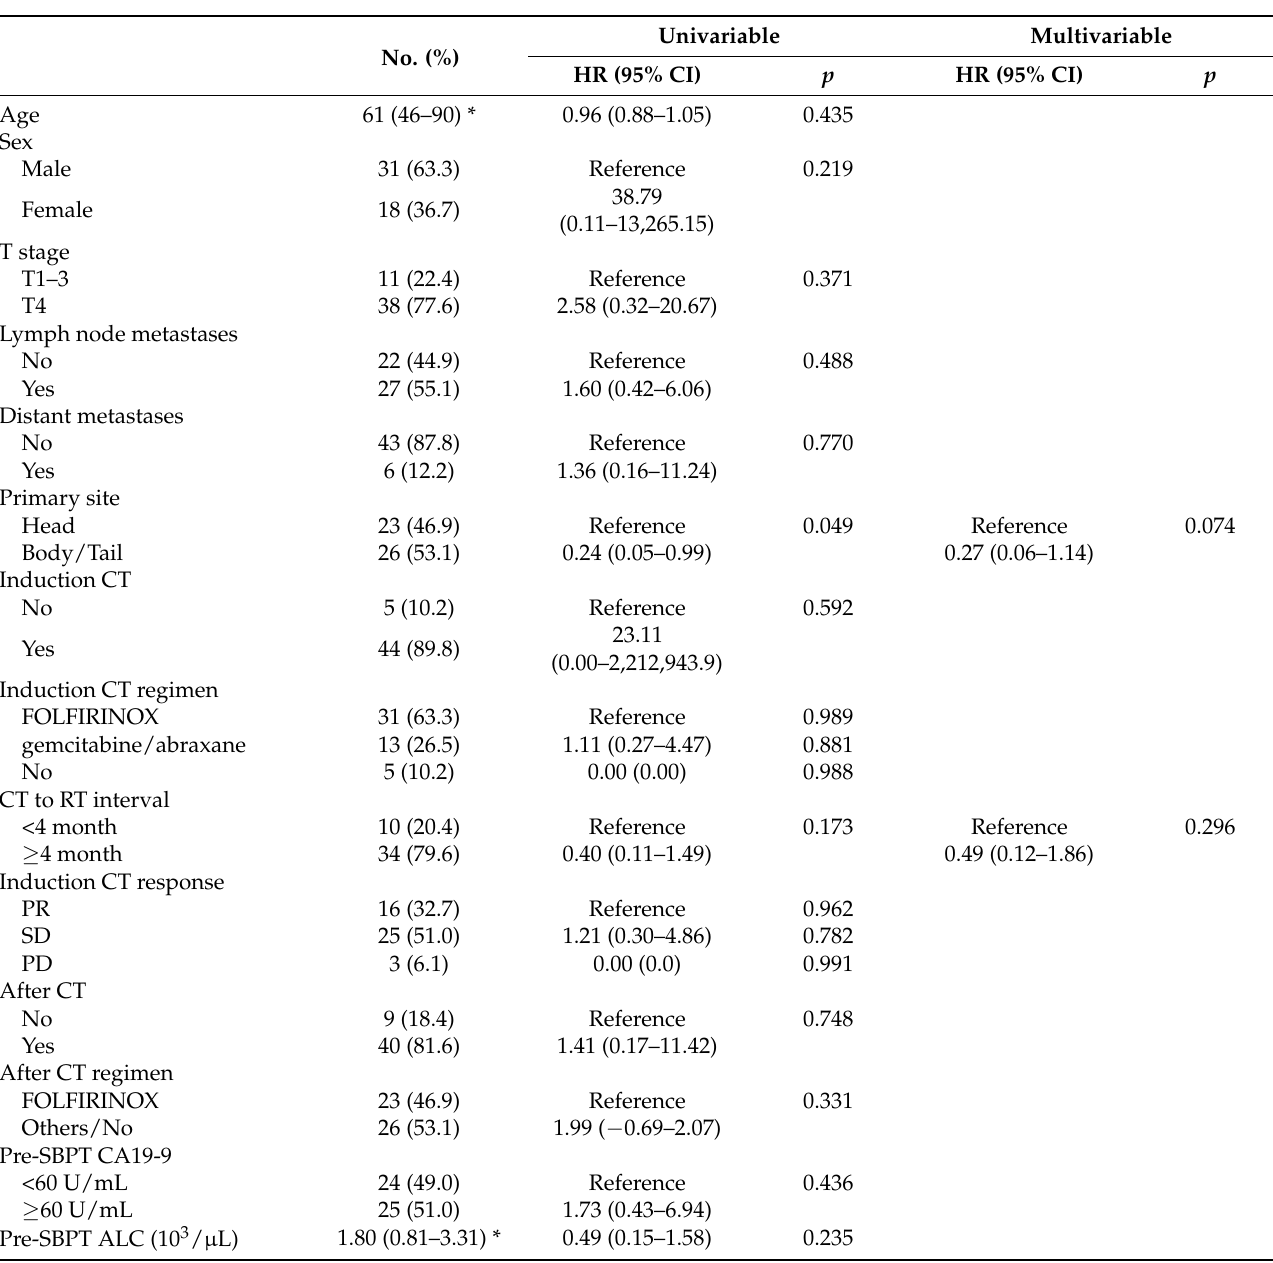
Abbreviations are as presented in the above table. * The values are presented as median